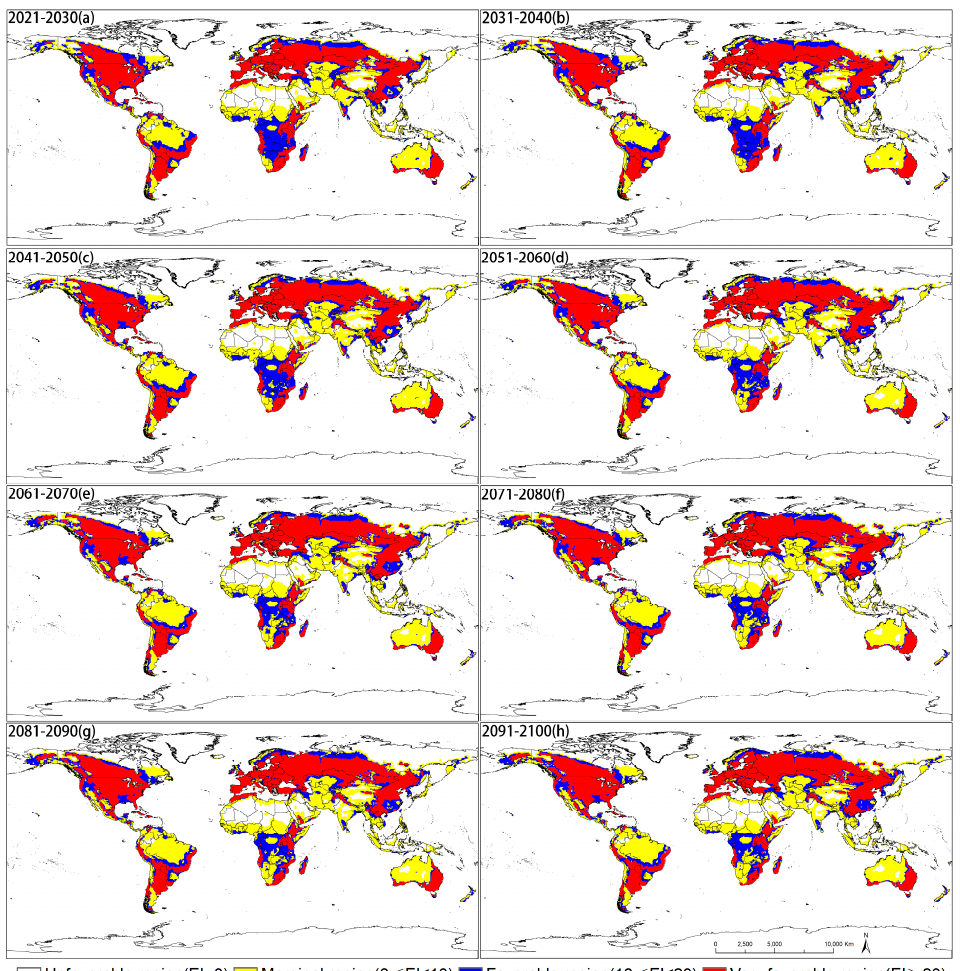
Figure 4. Predicted potential global distribution of D. ponderosae under future climate conditions. (a- h) Predicted potential global distribution of D. ponderosae for 2021–2030, 2031–2040, 2041–2050, 2051– 2060, 2061–2070, 2071–2080, 2081–2090, and 2091–2100. The unfavorable, marginal, favorable, and very favorable regions were painted in white, yellow, blue, and red, respectively.